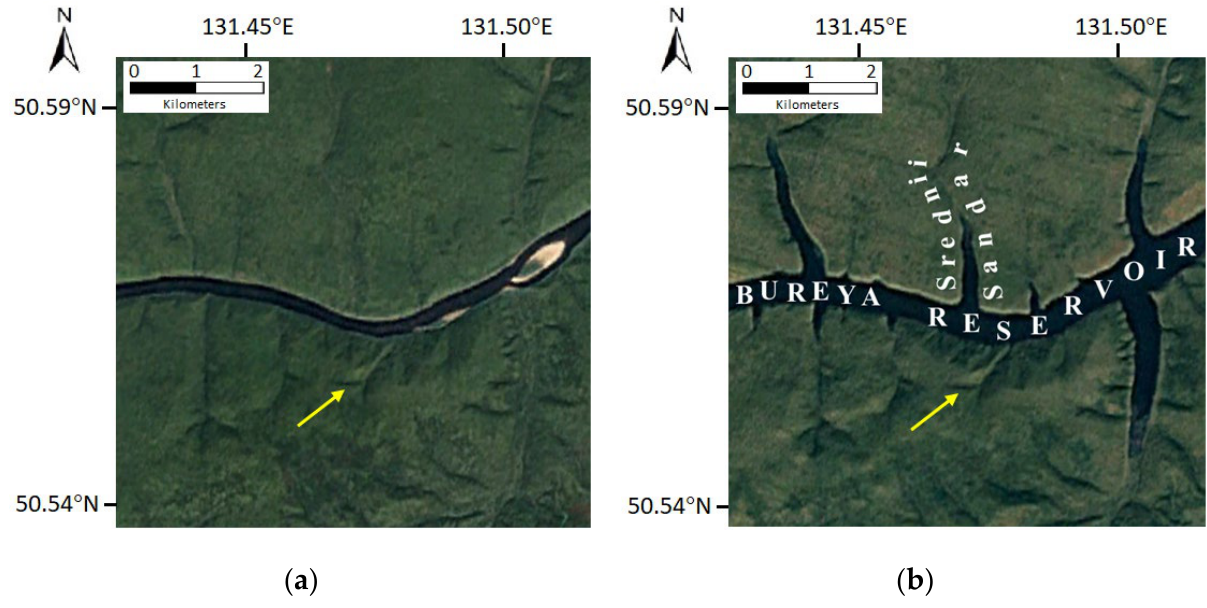
Figure 3. Google Earth image of landslide area in 2002 ( a ) и 2006 ( b ) with the landslide area marked by an arrow.